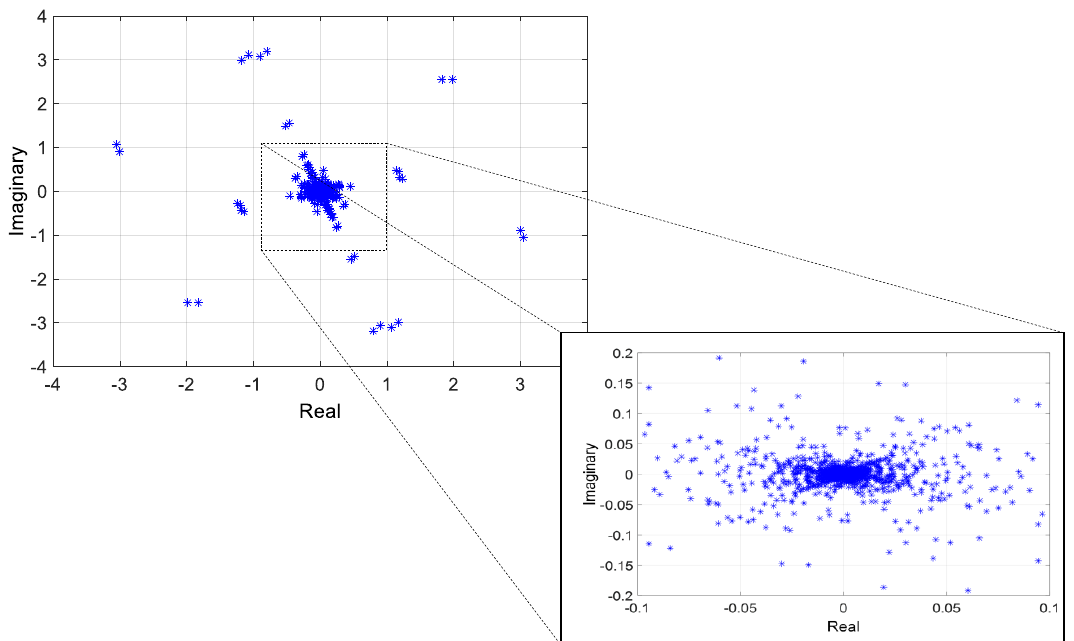
( ) 2 ( s ) for the case study of the test s  for the case study of the 20 s  for the case study of the 20 ( 1,2 ) ( ) 1,2 1,2